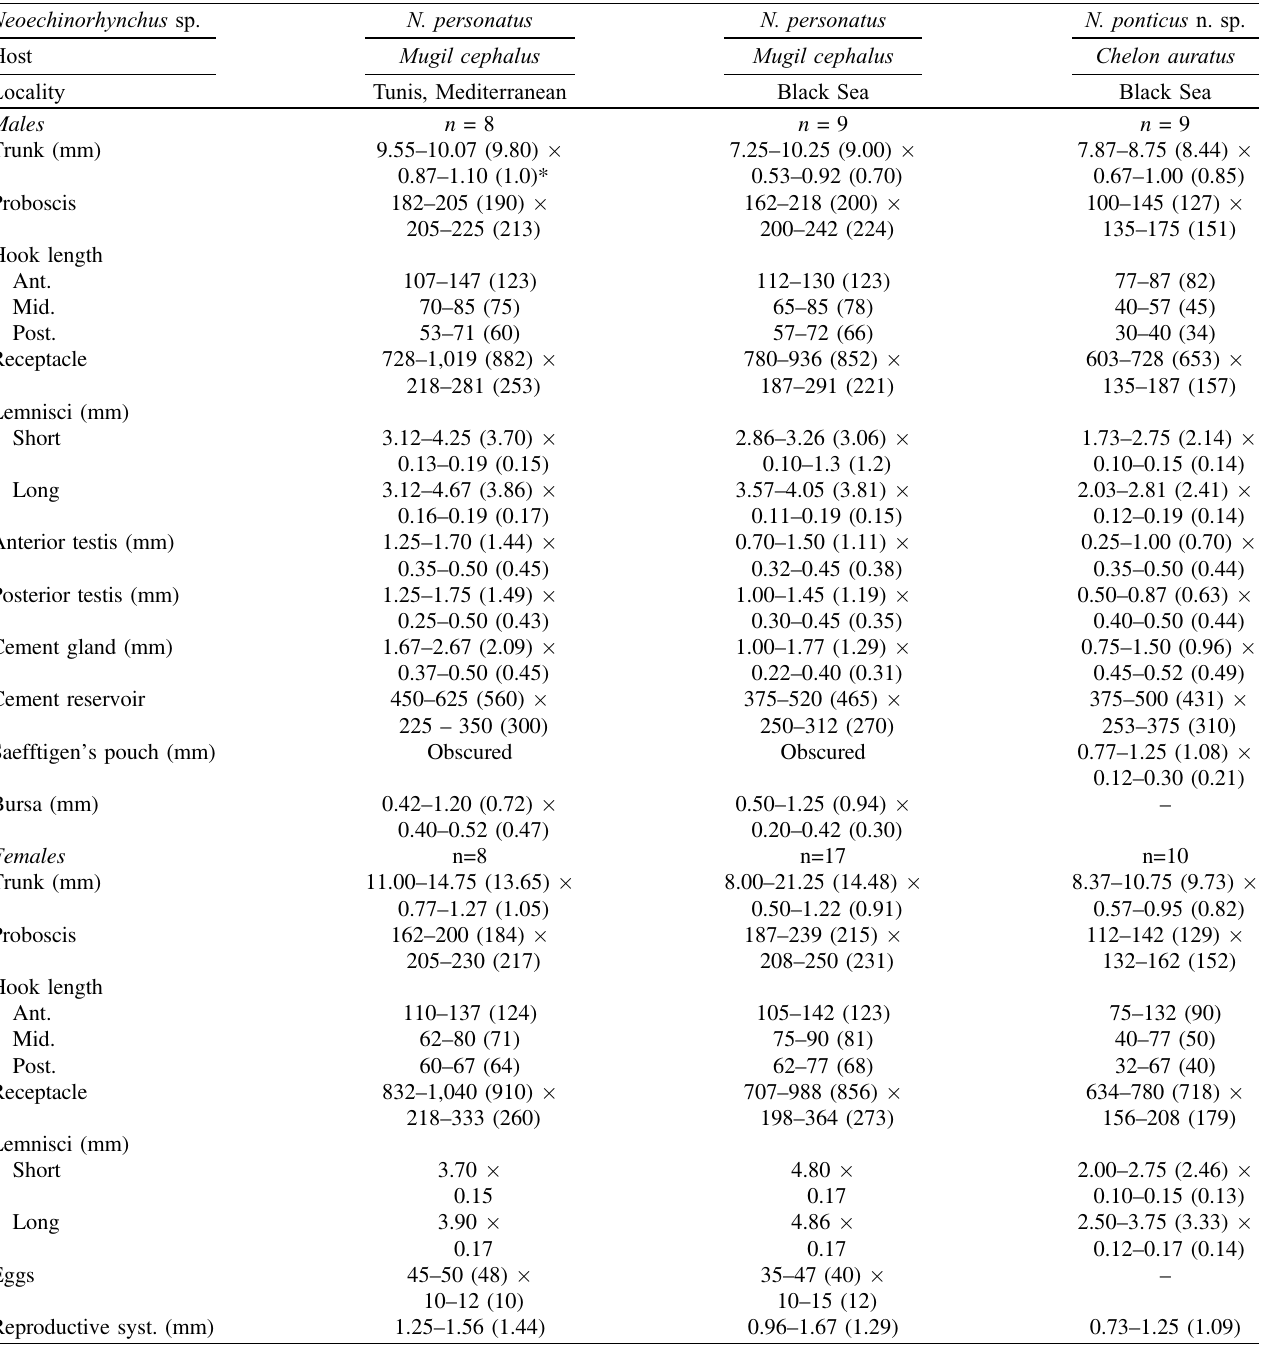
Table 2. Morphometric comparisons among species of Neoechinorhynchus from Mugil cephalus and Chelon auratus in the Mediterranean and the Black Sea in our collections. Neoechinorhynchus sp.